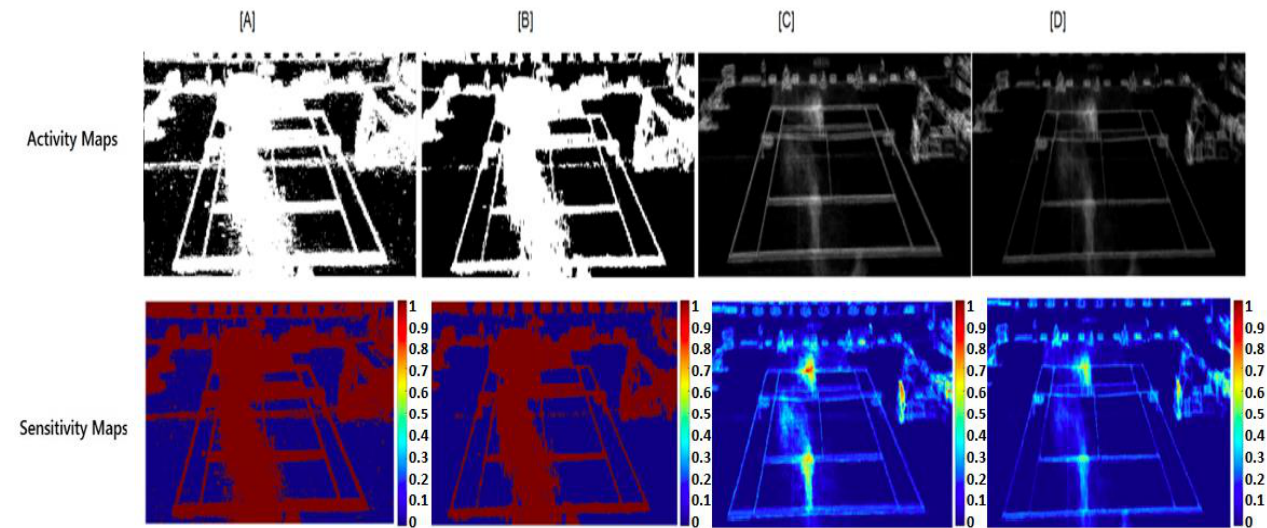
Figure 14. Simulation results from video dataset 6 by the proposed framework (( a ) extracted frames in grayscale, ( b ) foreground by adaptive background subtraction post-binarization and ( c ) optical flow).